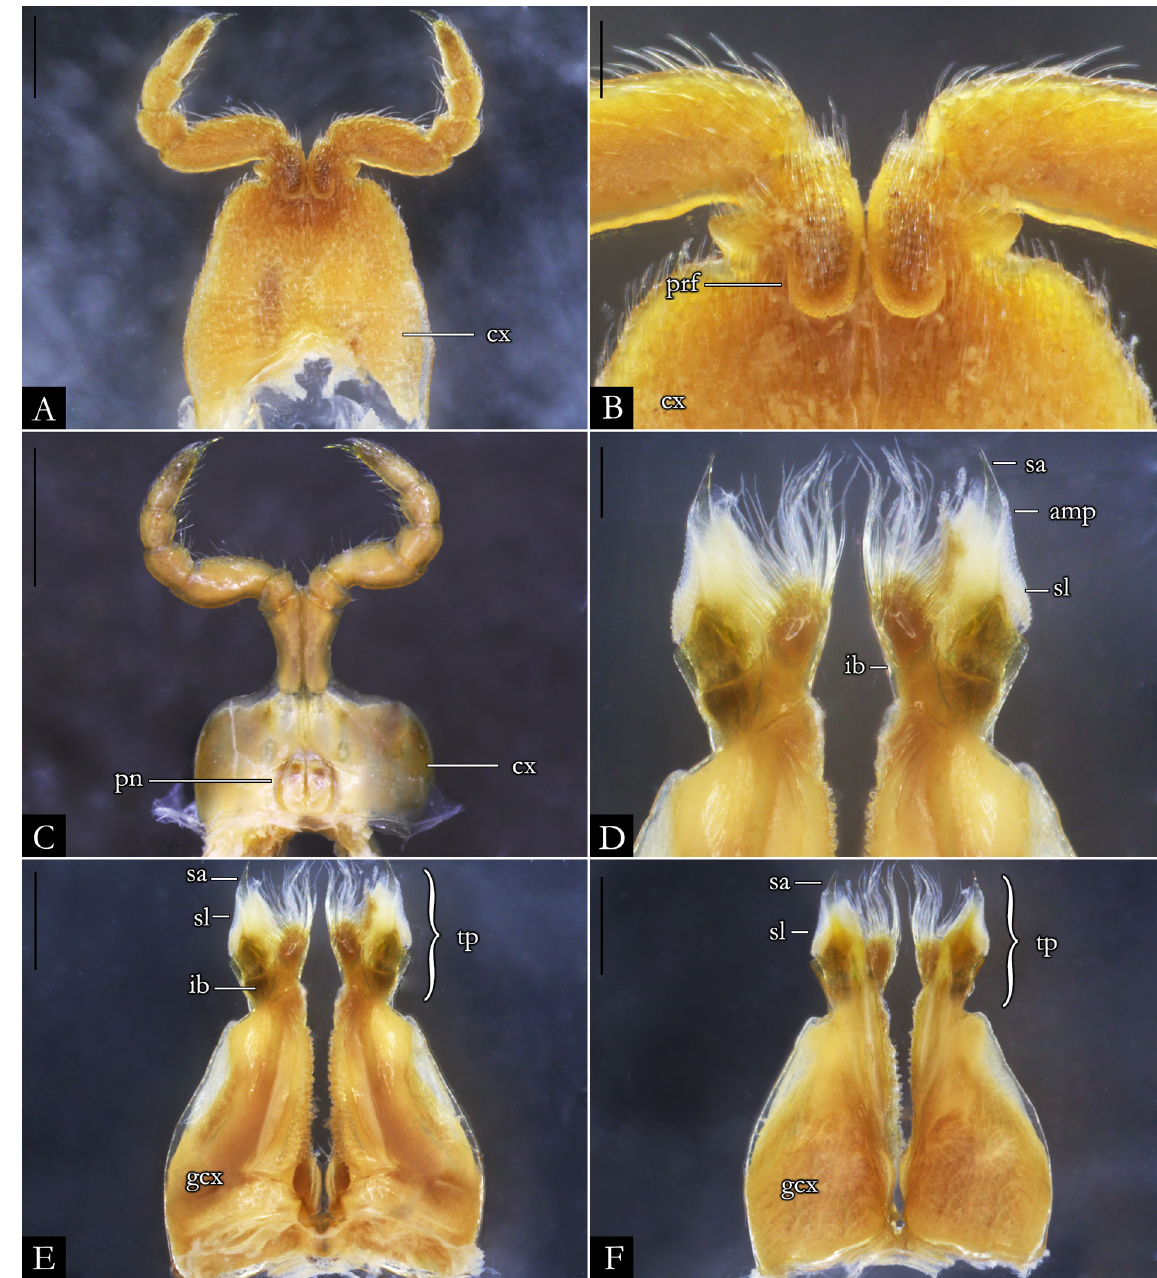
Fig. 90. Pseudonannolene maritima Schubart, 1949, ♂ (IBSP 658). A . First leg-pair. B . Detail of prefemur. C . Second leg-pair. D . Detail of telopodites, in anal view. E . Gonopods, in anal view. F . Gonopods, in oral view. Abbreviations: see Material and methods. Scale bars: A, C, E–F = 0.5 mm; B, D = 0.2